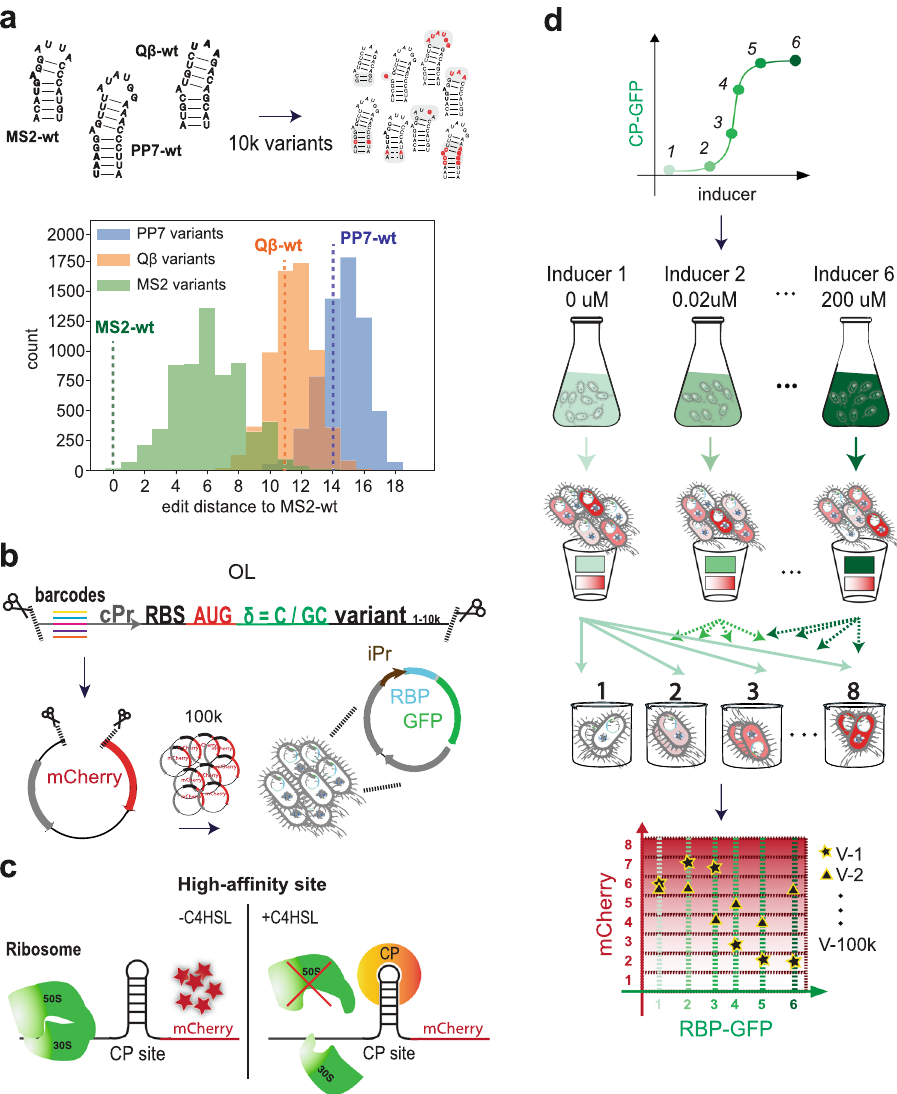
Fig. 1 iSort-seq overview in E. coli . a (Top) Wild-type binding sites for MS2, PP7, and Q β phage coat proteins and illustrations of the 20k mutated variants created based on their sequences. (Bottom) Composition of the OL library. Histogram of the number of PP7-based variants (blue), Q β -based variants (orange), and MS2-based variants (green) with different edit distances from the MS2-WT binding site. b Each putative binding site variant was encoded on a 210 bp oligo containing the following components: restriction site, barcode, constitutive promoter (cPr), ribosome binding site (RBS), mCherry start codon, one or two bases (denoted by δ ), the sequence of the variant tested, and the second restriction site. Each con fi guration was encoded with fi ve different barcodes, resulting in a total of 100k different OL variants. The OL was then cloned into a vector and transformed into an E. coli strain expressing one of three RBP – GFP fusions under an inducible promoter (iPr). The transformation was repeated for all three fusion proteins. c The schema illustrates the behavior of a high-af fi nity strain: when no inducer is added, mCherry is expressed at a certain basal level that depends on the mRNA structure and sequence. When inducer (C4-HSL) is added, the RBP binds the mRNA and blocks the ribosome from mCherry translation, resulting in a down-regulatory response as a function of inducer concentration. d The experimental fl ow for iSort-seq. Each library is grown at six different inducer concentrations, and sorted into eight bins with varying mCherry levels and constant RBP – GFP levels. This yields a 6 × 8 matrix of mCherry levels for each variant at each induction level. (Bottom) An illustration of the experimental output of a high-af fi nity strain (V1) and a no-af fi nity strain (V2). See Fig. S13 for fl ow cytometry gating strategy